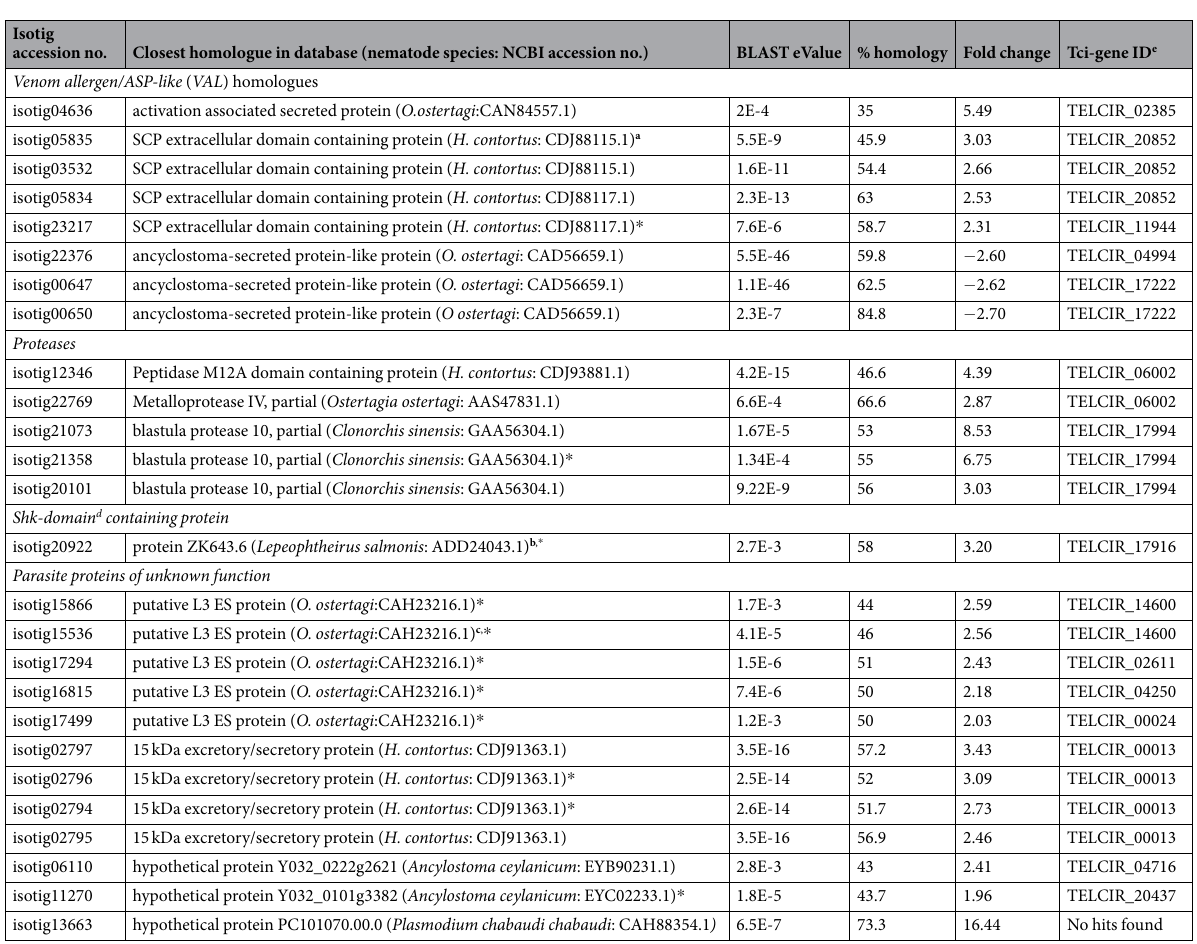
Table 2. Details of isotigs differentially expressed in mucosal vs. luminal T. circumcincta L4, with FDR adjusted p-value ≤ 0.05. * Denotes presence of a signal peptide. a Isotig represents Tci-ASP-2; b isotig